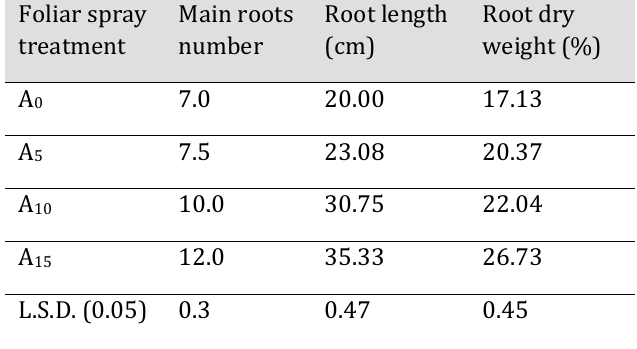
Table 3. Effect of foliar fertilization on roots characteristics of pear